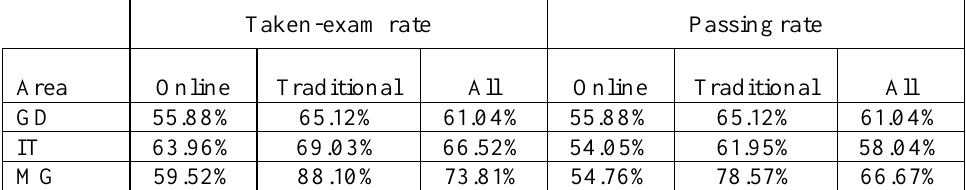
Taken-Exam and Passing Rates for GD, IT, and MG Courses Taken-exam rate Passing rate Area Online Traditional All Online Traditional All